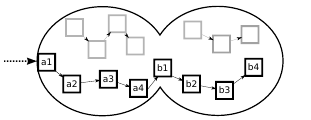
Figure 6: The two models have been composed. The second process is started by the first instead of the environment Now, only one process is started by the environment. What was once the second process, B , is now started at the end of A . A more complicated example occurs when the composition does not occur at the end of a process. In this case, the initial processes are shown in Figure 7. The sequence of actions for process A is A = input a 1 , a 2 , delay, a 3 , a 4 output and the sequence ! ! b 1 , b 2 , b 3 , b 4 output . for process B is B = input ! !